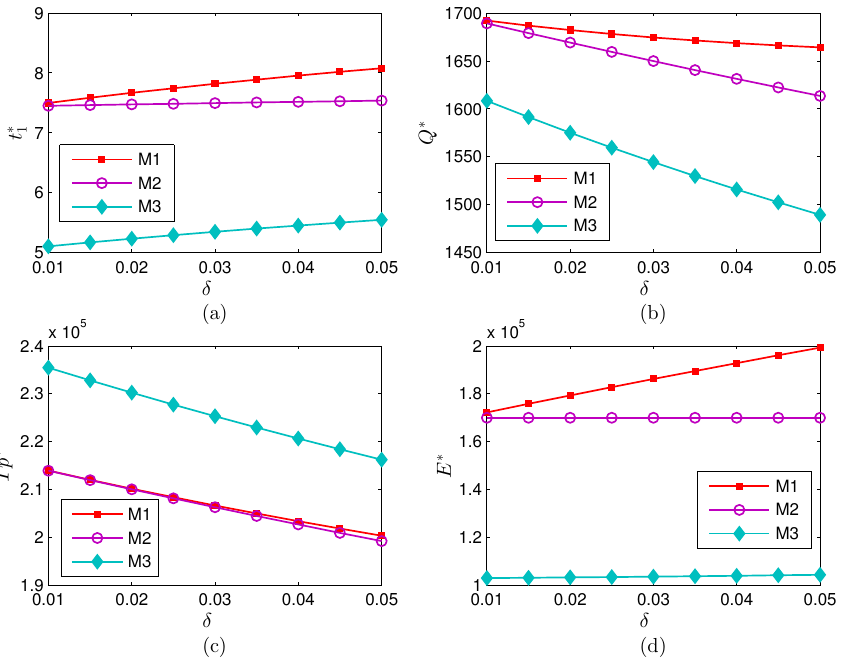
Figure 3. The impacts of the coefficient of lost sales on the optimal inventory performance. ( a ) Comparison of the optimal time point with lost sales. ( b ) Comparison of the optimal order quantity with lost sales. ( c ) Comparison of the optimal total profit with lost sales. ( d ) Comparison of the optimal total carbon emissions with lost sales.